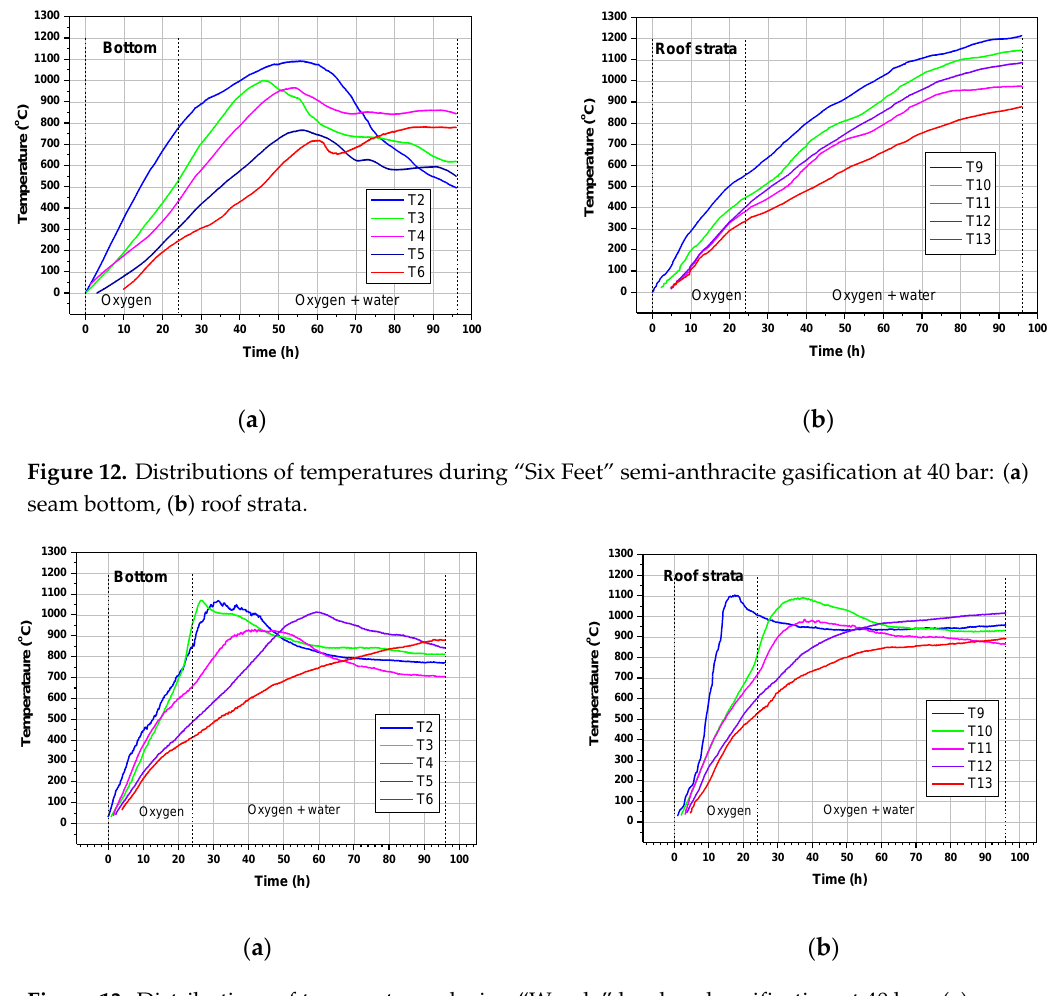
Figure 13. Distributions of temperatures during “Wesoła” hard coal gasification at 40 bar: ( a ) seam bottom, ( b ) roof strata.